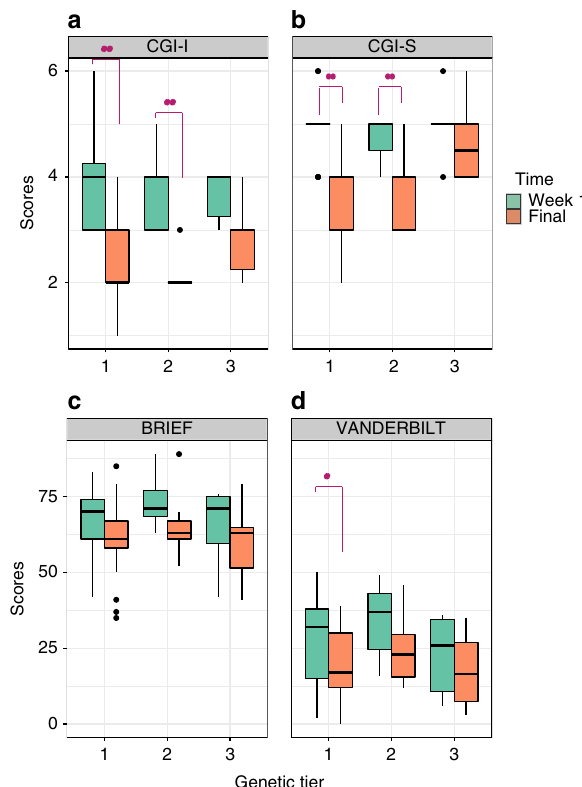
Fig. 2 Net differences in the distribution of a CGI-I, b CGI-S, c Vanderbilt, and d Brief global scales between week 1 (placebo; green) and the fi nal (max dose; orange) week of the study shown as box plots. Patients were strati fi ed by genetic tier group allocation. P -values denote results of the paired Student ’ s t -test between results from study baseline (week 1) and fi nal (week 5) for each tier. Statistically signi fi cant comparisons are highlighted with red asterisks. N = 30. The edges of the box plots denote 25 and 75% tiles, while the solid black horizontal line denotes the cohort median. Upper and lower whiskers denote the limits of the nominal range of the data inferred from the upper and lower quartiles (see Methods) and plotted points are outliers from these